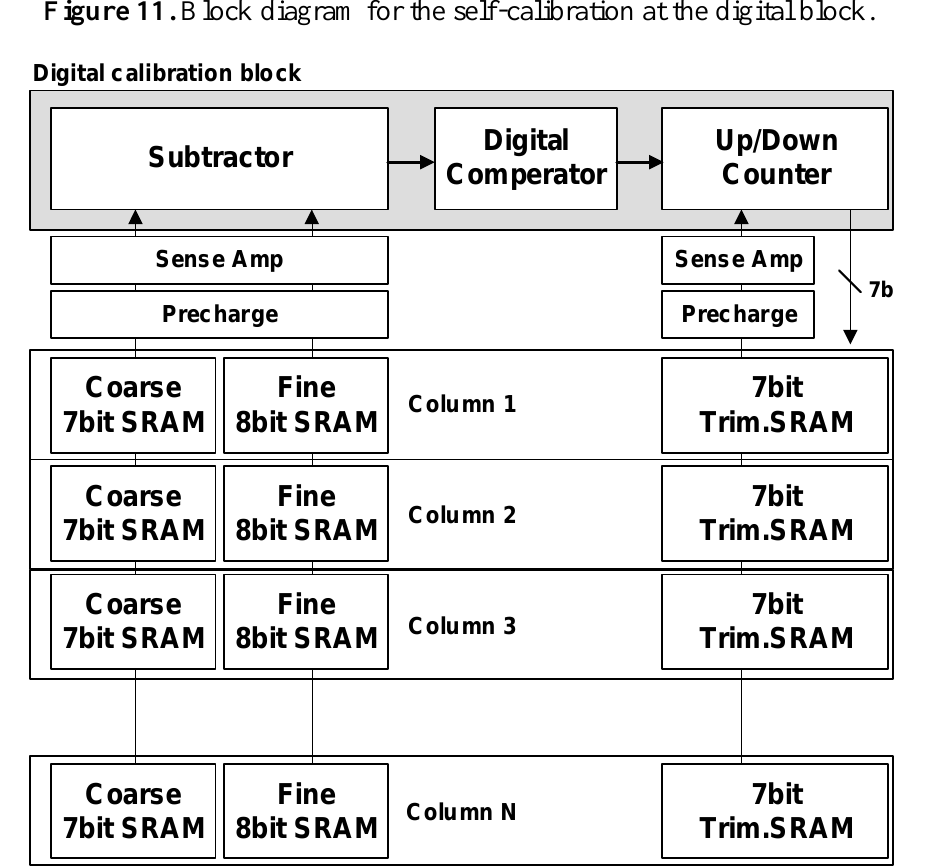
Figure 11. Block diagram for the self-calibration at the digital